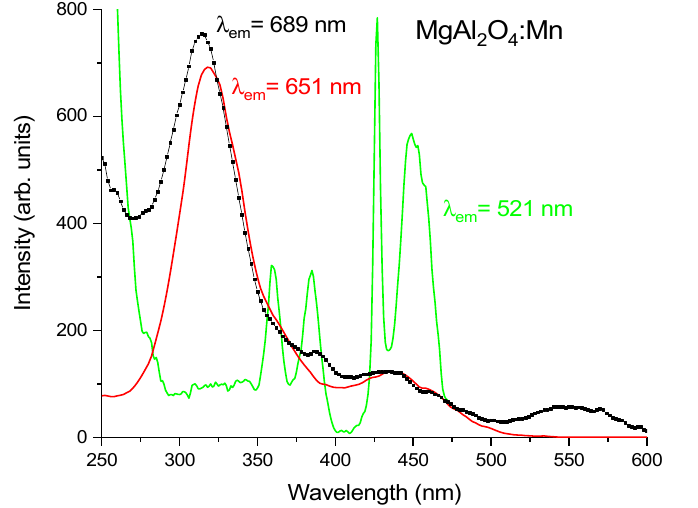
Figure 6. PLE spectra of sample II, i.e., MgAl 2 O 4 :Mn, measured at 290 K by monitoring different emission wavelengths.